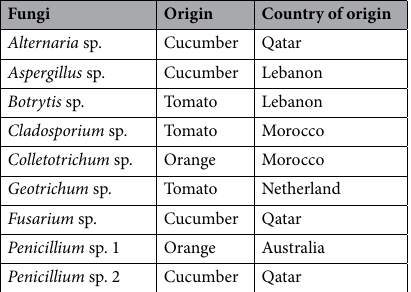
Table 6. Fungal strains used in the in-vitro analysis study.